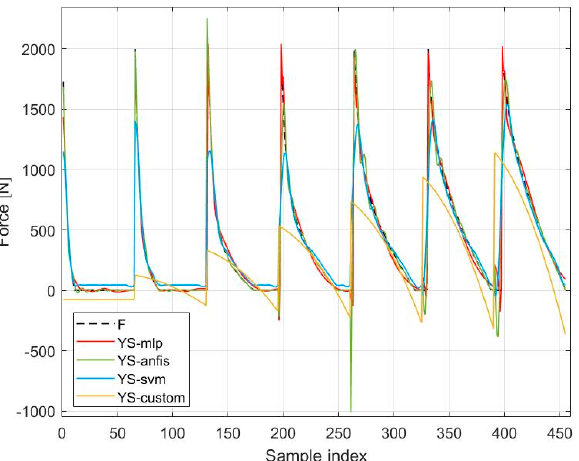
Figure 14. Comparison of the model outputs with the force measured by FESTO for the DMSP − 40 muscle. An overview of the model outputs, summarizing all of the outputs of the best models in one graph together with the measured data for the DMSP − 20 muscle, is shown in Figure 15. The measured tensile force is indicated by the black dashed line marked F. The outputs of the individual models are shown by solid colored lines: